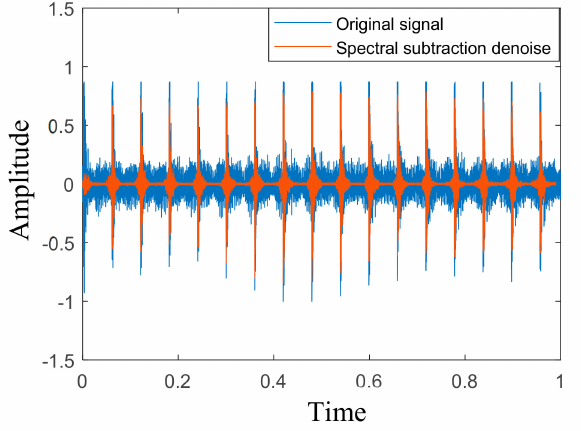
Figure 3. The compared results with spectral subtraction denoising.